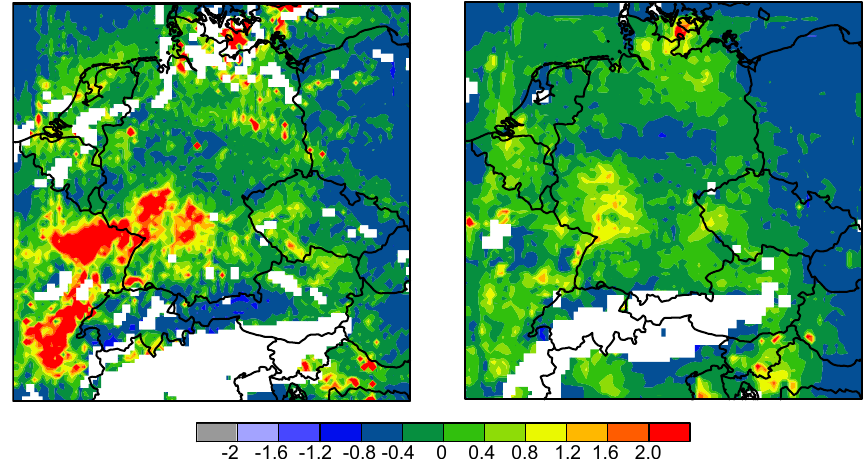
Figure 6. Mean normalized bias in AOD (dimensionless) from comparison with MODIS measurements. Two different products were used, Level 2 (left) and data with additional quality assurance filters according to Hyer et al., 2011 (right). Simulated values of AOD were consid- ered for times and locations with available MODIS